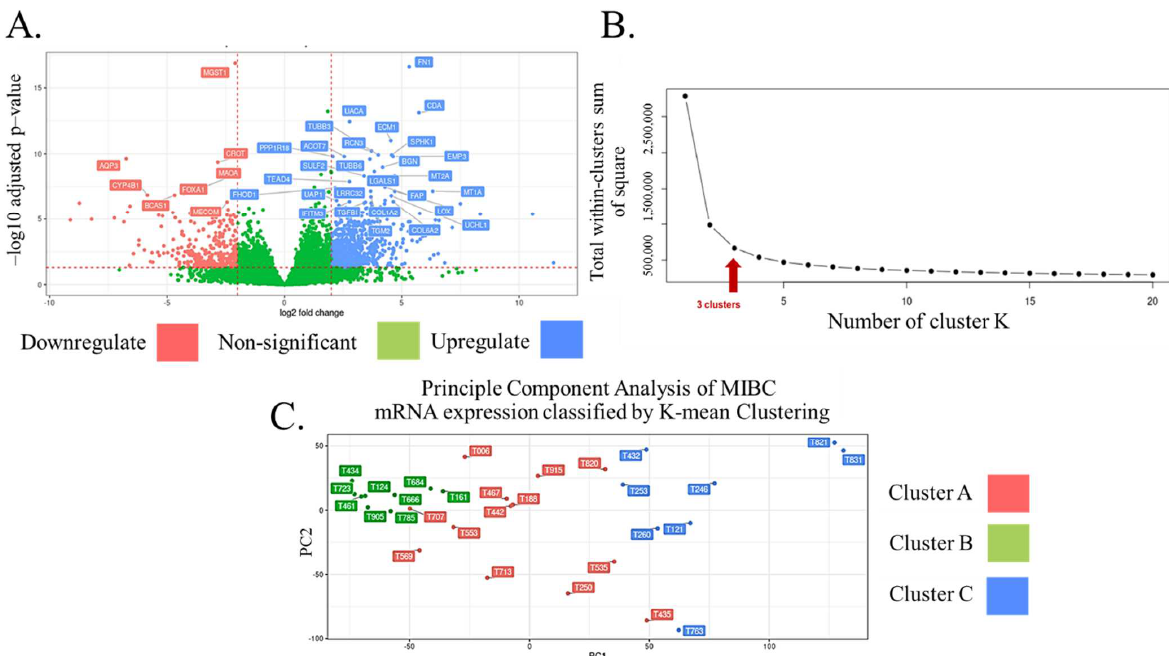
Figure 1. ( A ) Volcano plot analysis demonstrated that more than 100 genes were found to be upregulated and downregulated in MIBC. ( B ) Elbow plot analysis was applied for Thai MIBC transcriptome data. The results show that the three clusters were found to be optimal. ( C ) The transcriptomic data of all MIBC tissue samples were then subjected to the classification of the MIBC groups by using principal component analysis by K-means clustering. The genes were ranked by adjusted p - value.